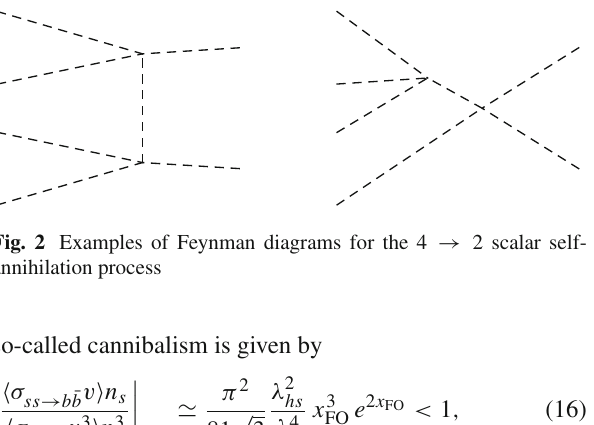
Fig. 3 DM freeze-out with cannibalism. Parameter space giving rise to the observed DM relic abundance, for λ hs = 10 − 3 . The red region corresponds to λ s >